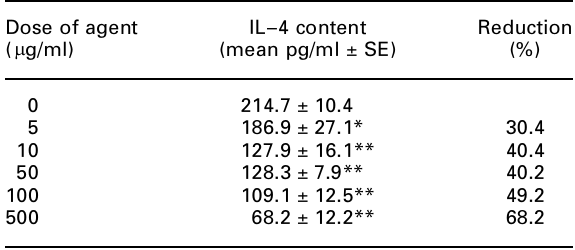
Table 2. Influence of IPD–1151T on in vitro IL–4 production by spleen cells in response to Con A stimulation